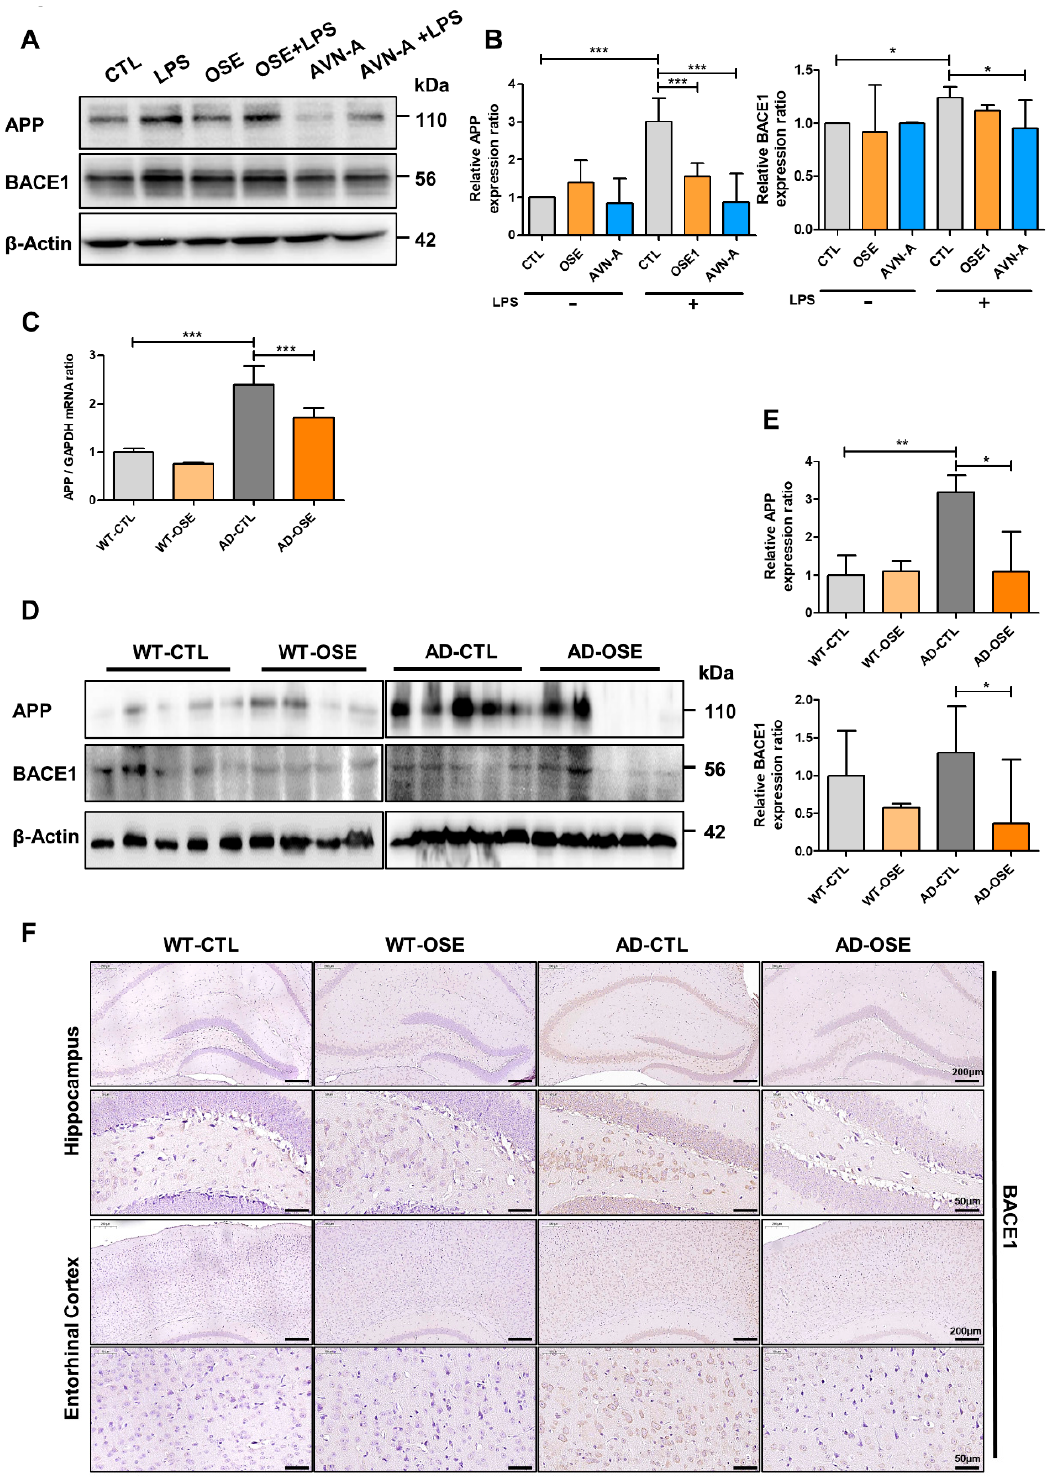
Figure 3. Effects of OSE in different expressions of APP and BACE1 in WT and Tg-5xFAD AD mice brains. ( A ) Western blotting in the HT22 cell line after exposure to OSE and AVN-A. ( B ) Validation of differentially expressed proteins by Western-blot analysis. ( C ) RT-PCR for APP performed using whole brain tissues from WT and Tg-5xFAD AD mice with or without OSE exposure. ( D ) BACE1 Western blotting in the cortex extract, as well as hippocampus, within both WT and Tg-5xFAD AD mice after exposure to OSE. ( E ) Validation of differentially expressed proteins by Western-blot analysis. ( F ) Representative images of BACE1 in the CA1 region of the hippocampus and entorhinal cortex of Tg-5xFAD AD and WT mice. * p < 0.05, ** p < 0.01, *** p <